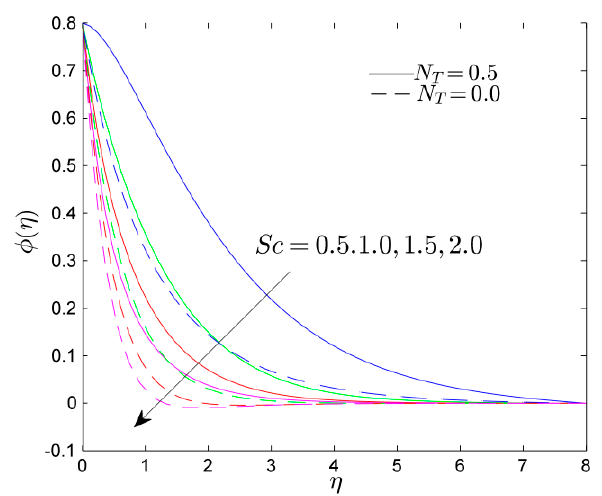
(cid:0) (cid:1) ω φ on φ ( η ) .